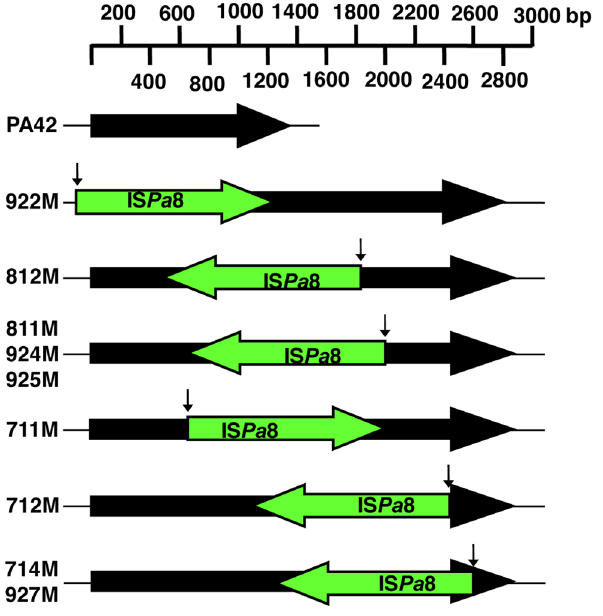
Figure 2. Insertion sites of IS Pa 8 with respect to the oprD gene in PA42 and nine isogenic mutants. The solid black arrows represent the oprD gene while the green arrows represent the location and orientation of IS Pa 8 within oprD . The downward arrow indicates the predicted insertion site of IS Pa 8 within oprD as determined by sequence